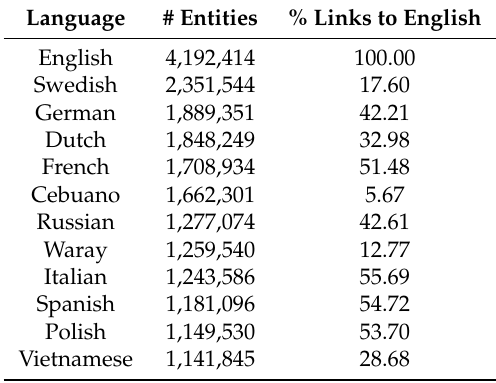
Table 7. Size of the 12 largest language editions of Wikipedia, and percentage of articles linked to